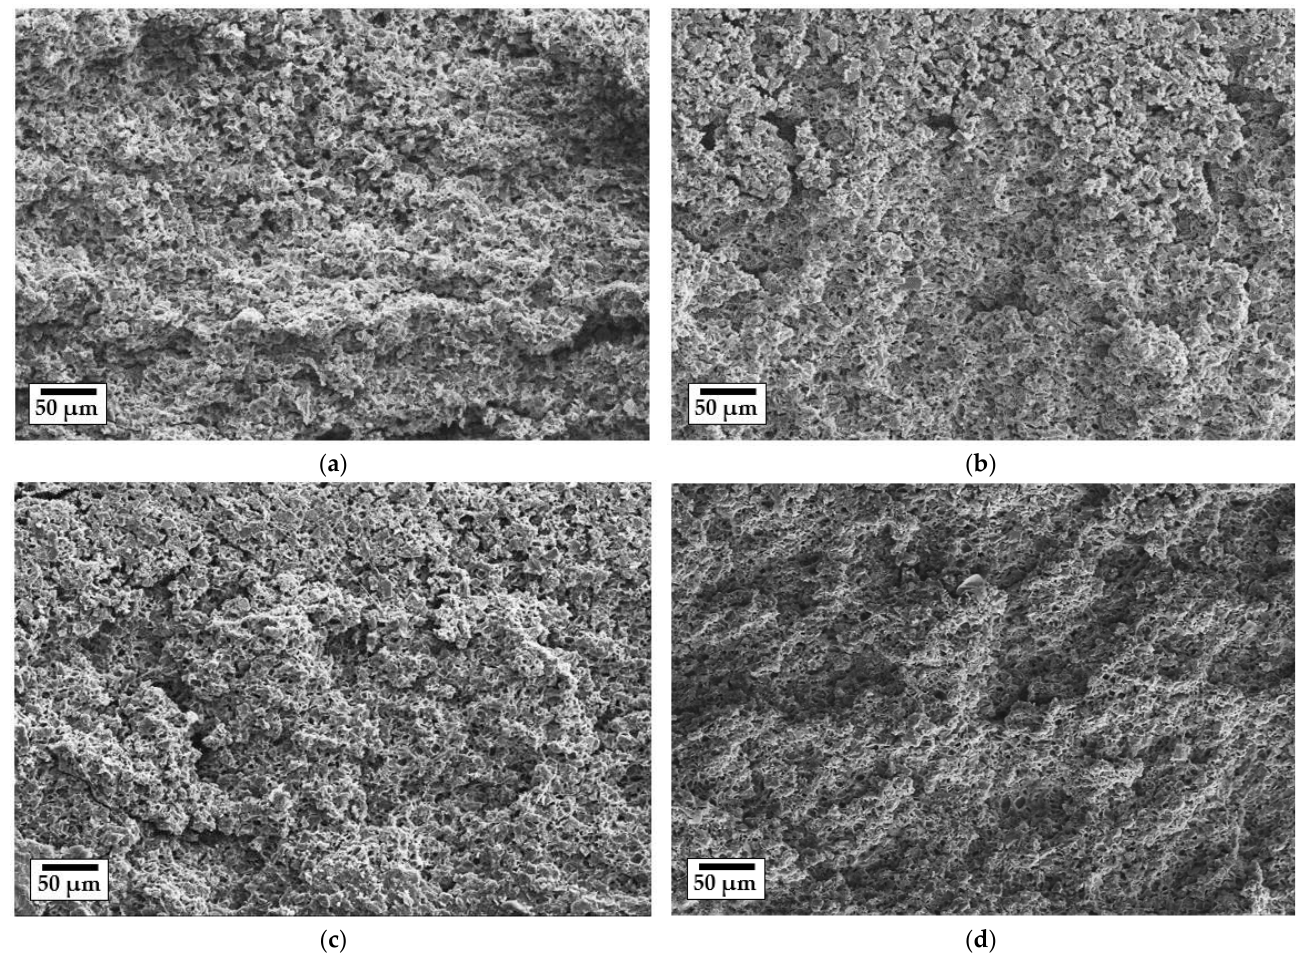
Figure 3. SEM images of the cross-section area of the membranes: ( a ) T0-Si59_600, ( b ) T10-Si49_600, ( c ) T10-Si49_800, and ( d ) T10-Si49_1000. ( c ) T10-Si49_800, and ( d )